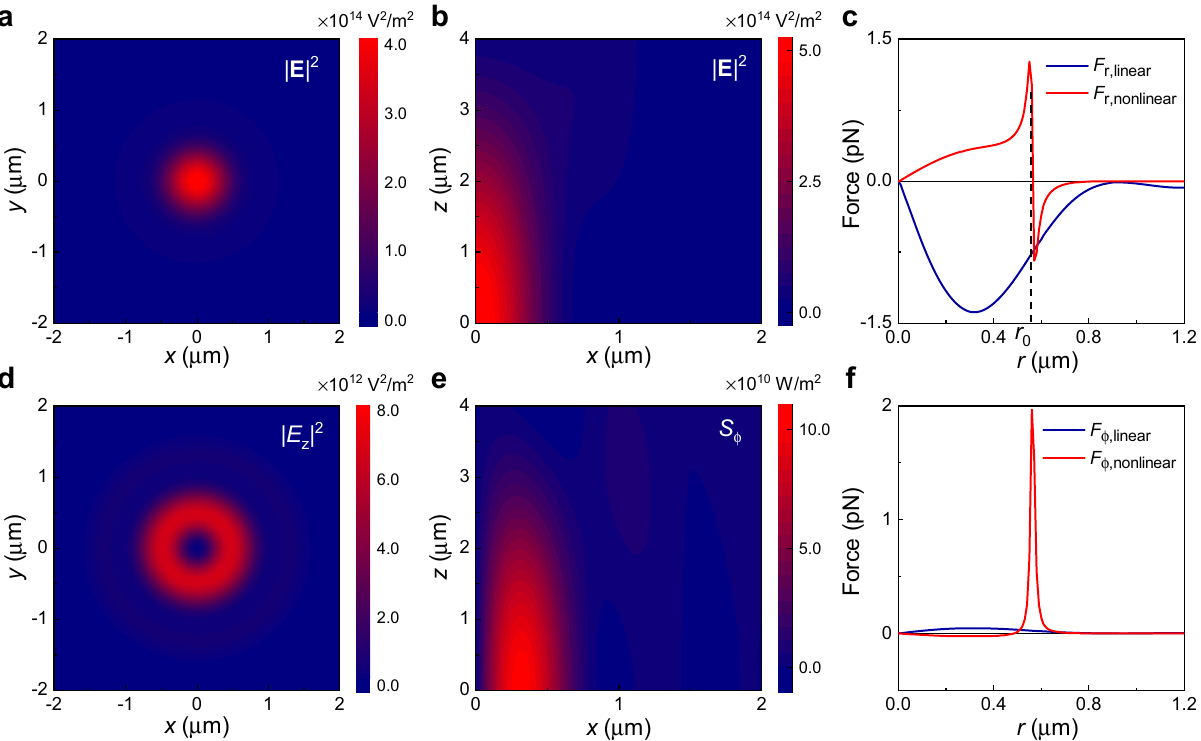
Fig. 3 The focused incident fi eld and the force acting upon a nonlinear particle. a , b The transverse ( a ) and longitude ( b ) electrical fi eld | E 2 | distribution of the strongly focused circular polarized incident beam at z ¼ 1 : 3 μ m. Incident beam with power P ¼ 500 mW focused by a lens with NA = 0.65 in water. c A typical example of F r with χ 3 ð Þ ¼ 2 ´ 10 (cid:2) 18 m 2 = V 2 , which has been decomposed into F r ; linear (red line) and F r ; nonlinear (blue line). d The E z distribution of the focused incident fi eld, which will induce the azimuthal direction energy fl ux S ϕ as shown in Fig. 3 e . f The azimuthal accelerating force F ϕ with its linear and nonlinear component caused by S ϕ